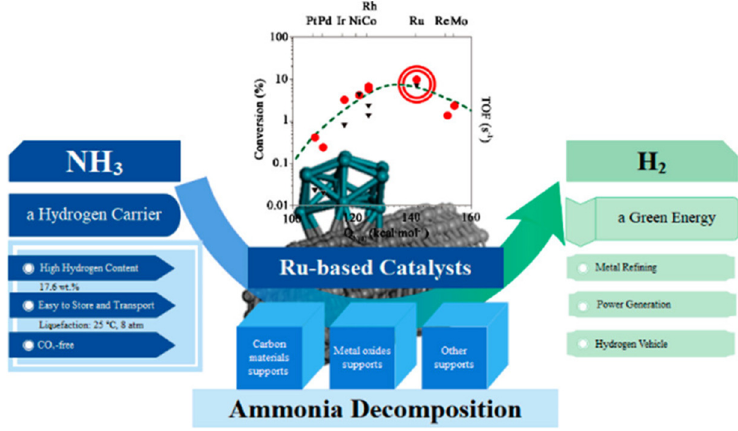
Figure 30. Ru-based catalysts for ammonia decomposition. Reprinted with permission [115].